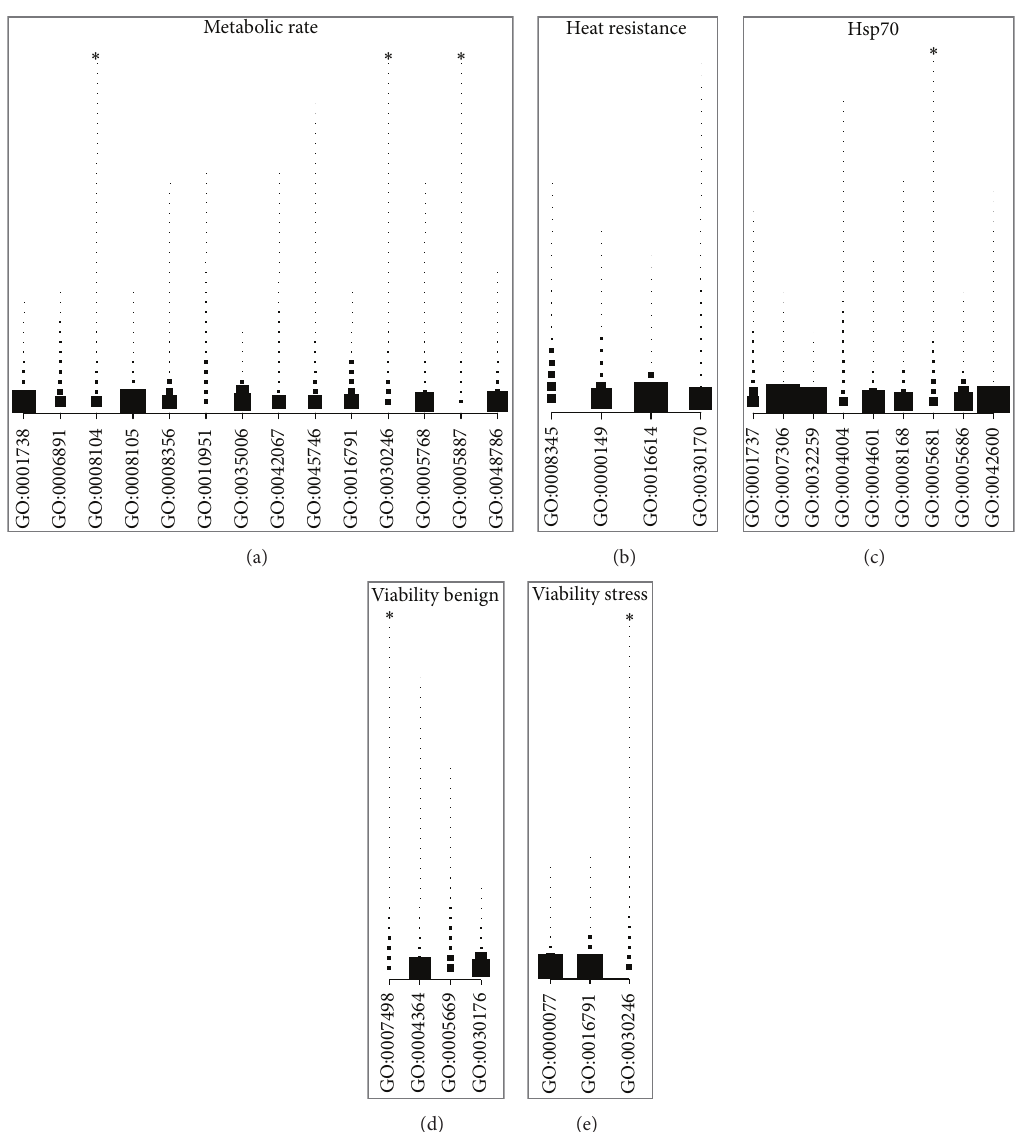
Figure 2: Partitioning of genetic variance of associated GOs to the genes constituting each GO. Proportion of variance per gene (per SNP) was standardized. Each square indicates one gene, and the size of the point indicates the relative proportion of variance explained by that gene. Asterisks ( ∗ ) indicate a truncation of the gene list. The exact values and the gene IDs can be found in Supplementary Table